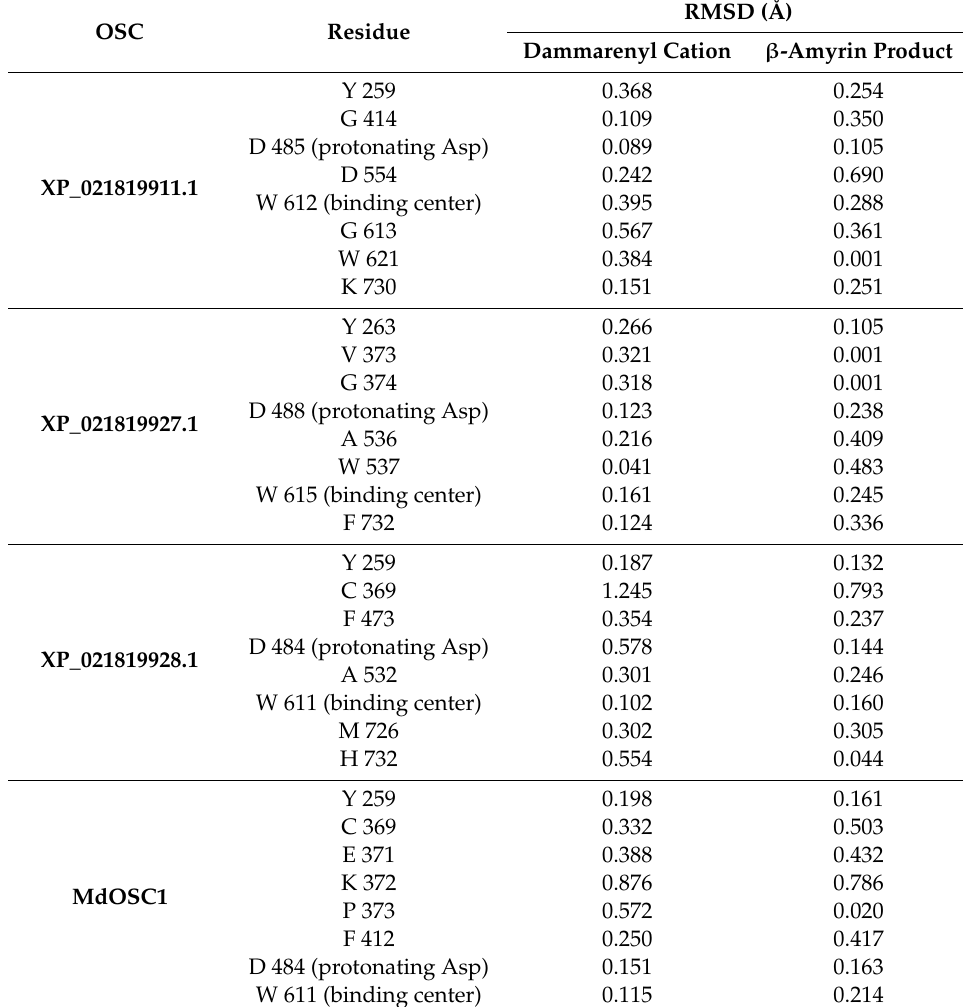
Table 1. RMSD values of some key residues surrounding the active site after the induced-fit docking of a cation intermediate and a product on fruit